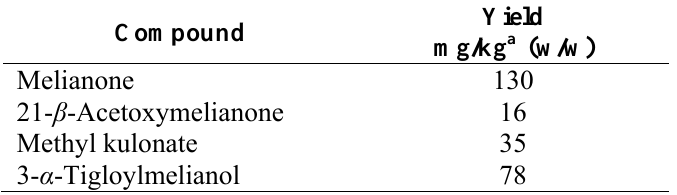
Table 1. Yield of tirucallane triterpenoids from dried fruits of Melia azedarach